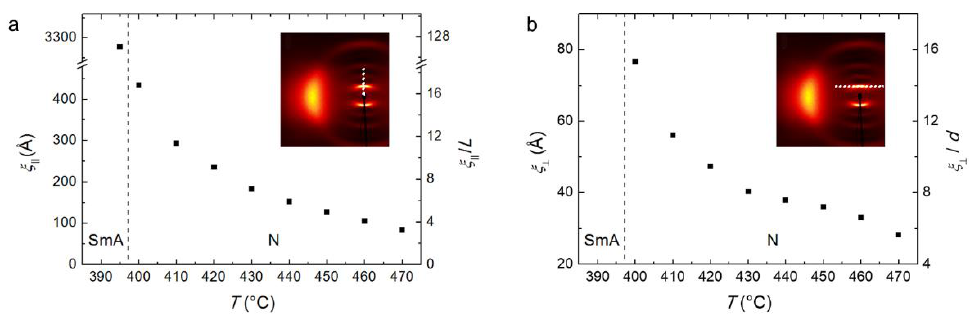
Figure 16. Cybotactic order correlation lengths in PPNPP as a function of temperature: ( a ) longitudinal correlation length, ξ (cid:107) , and its ratio with the molecular length L ; ( b ) transverse correlation length, ξ ⊥ , and its ratio with the transverse intermolecular distance d . Correlation lengths were obtained from the full width at half maximum (FWHM) of the low-angle peak measured along the cuts shown in the two insets. Panel ( a ) adapted from [59] with permission from The Royal Society of Chemistry.